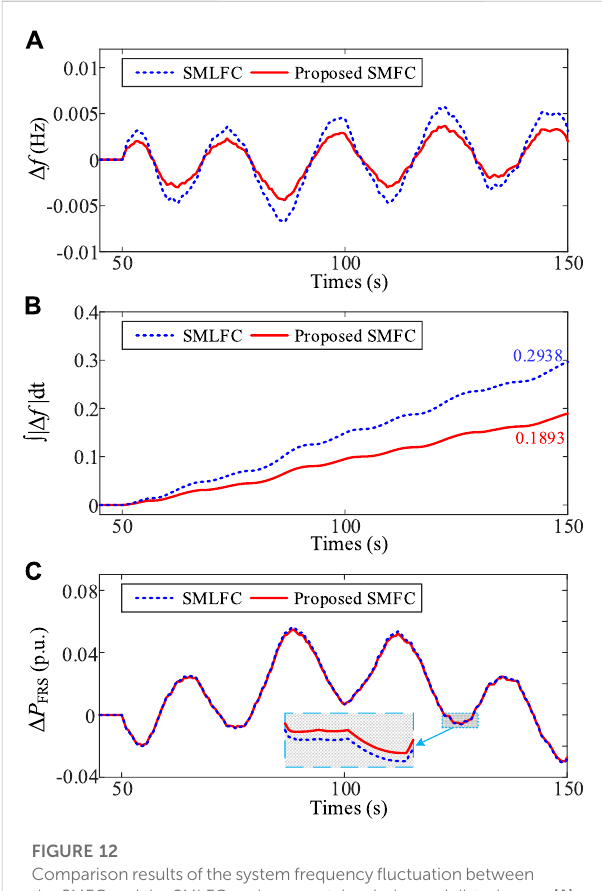
FIGURE 11 Comparisonresultsofthesystemfrequency fl uctuationbetween theSMFCandtheSMLFCunderuncertainloaddisturbance. (A) System frequency fl uctuation. (B) Totalfrequency fl uctuationlevel , | Δ f |dt. (C) Power output deviation of FRS.